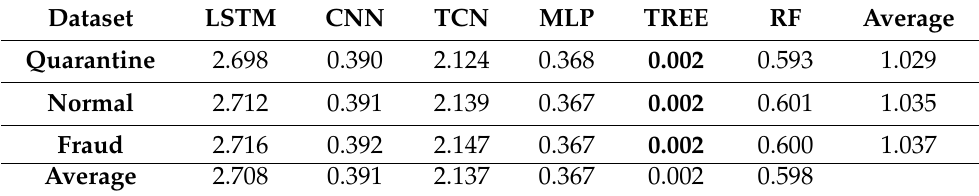
Table 13. Time results in seconds for each period and each model. The results in time were obtained by calculating the average of each of the times used to train each of the models in the parameter optimisation process.